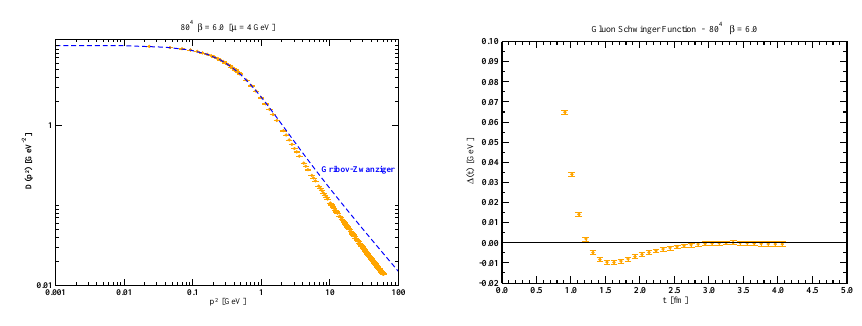
Figure 1. (Left) Renormalized lattice Landau gluon propagator taken from [6], renormalized in the MOM scheme at the scale µ = 4 GeV and (right) the corresponding Schwinger function.